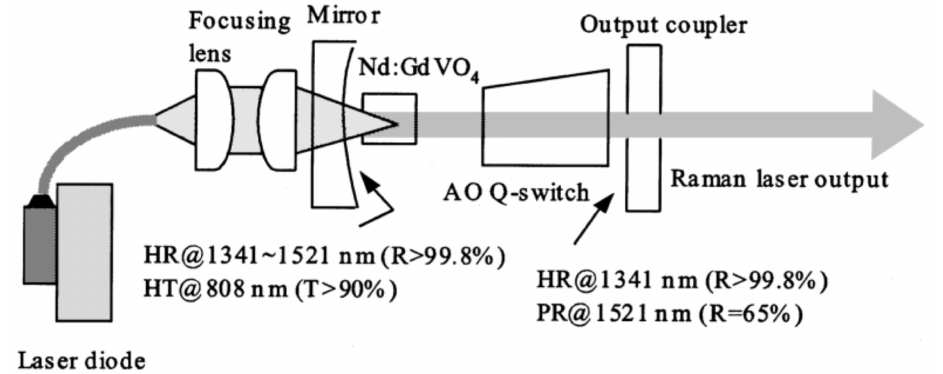
Figure 2. Schematic of actively Q-switched Nd:GdVO 4 self-Raman laser